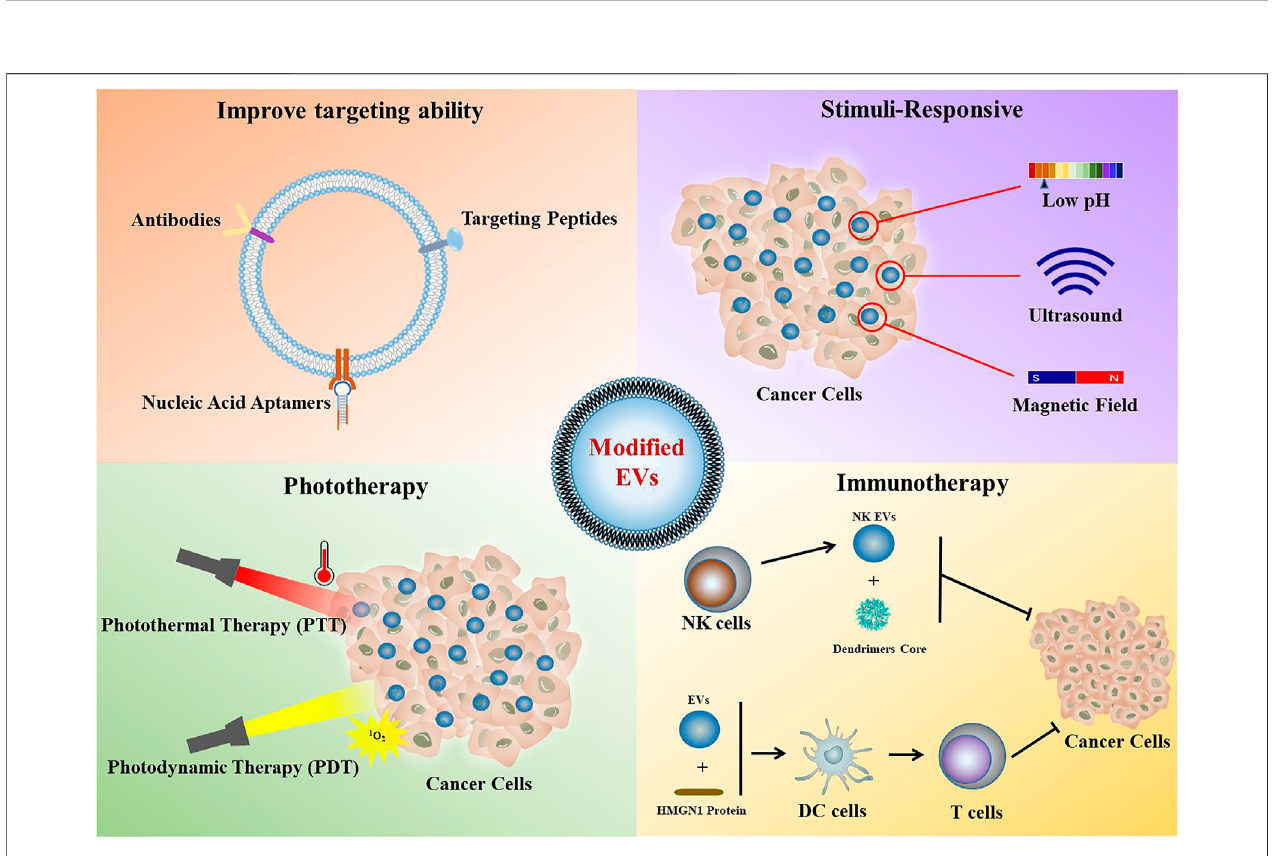
FIGURE 1 | Application of modi fi ed EVs in cancer